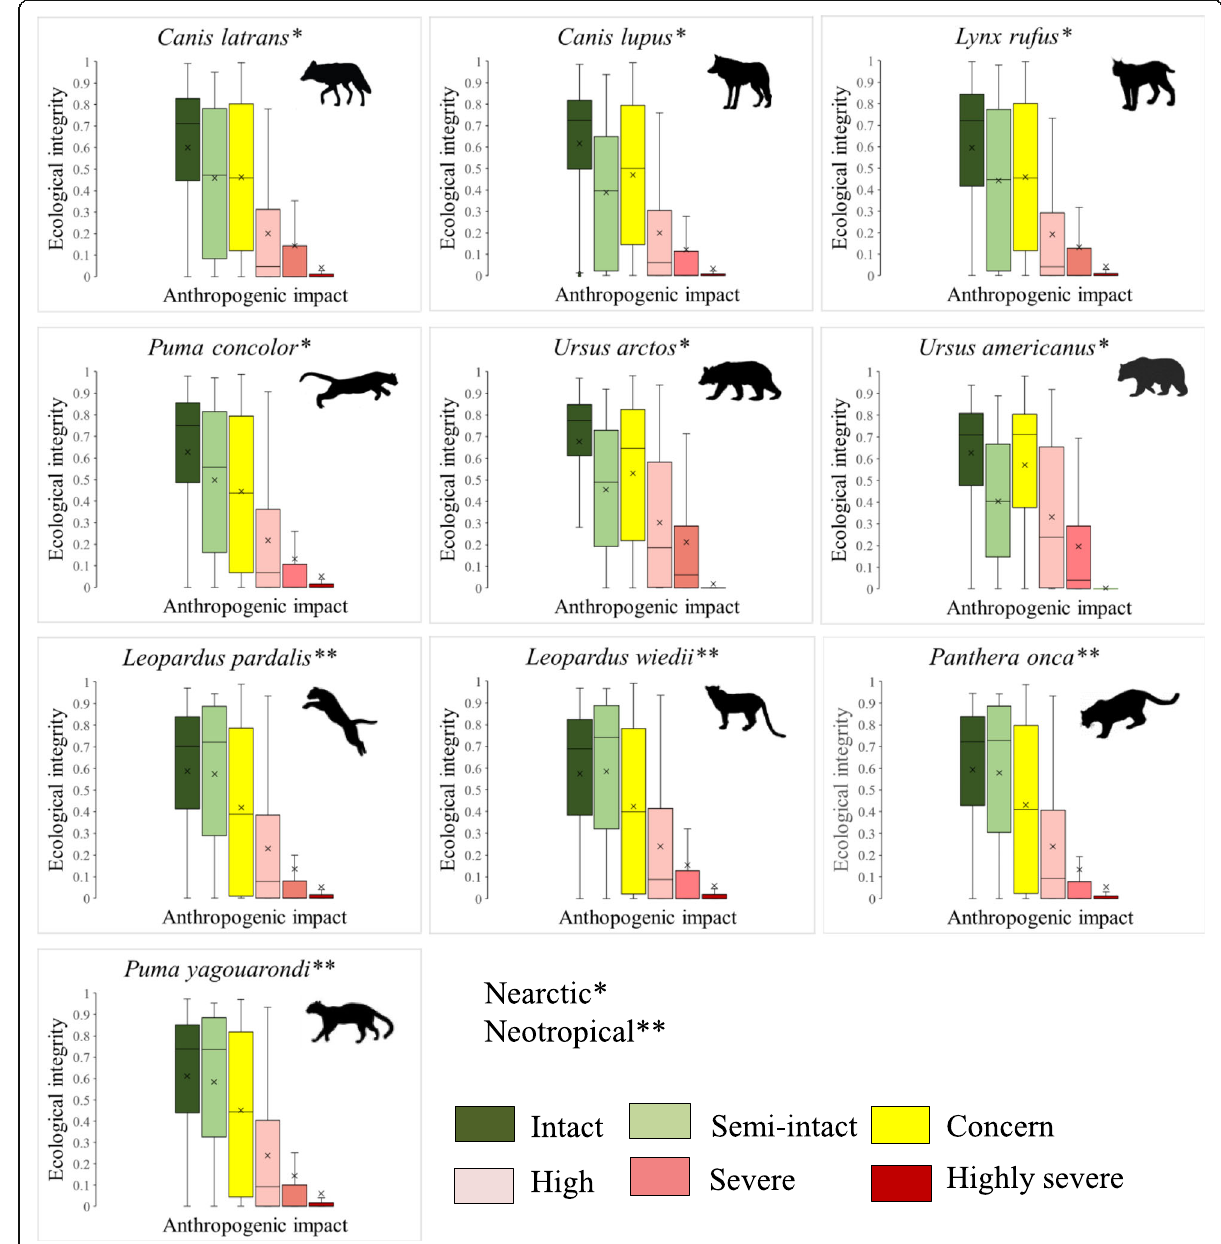
Fig. 8 Ecological integrity characterization for all Nearctic and Neotropical apex predators and all impact classes identified within their distributions areas in Mexico. As observed an inverse relationship between ecological integrity and anthropogenic impacts holds for all apex predators in their distribution